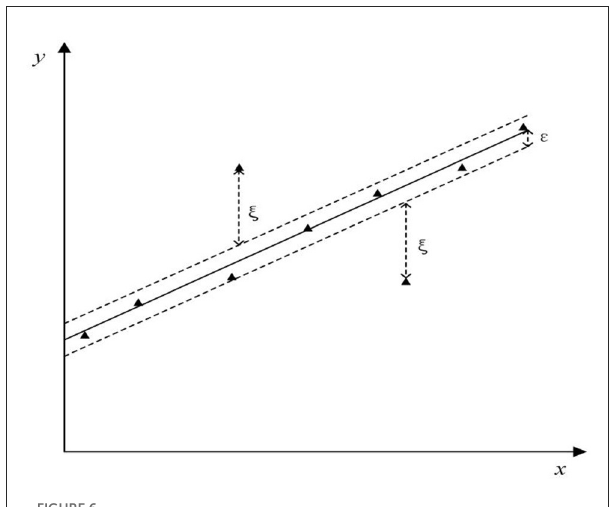
FIGURE6 ε − SVR regression error bound. FIGURE7